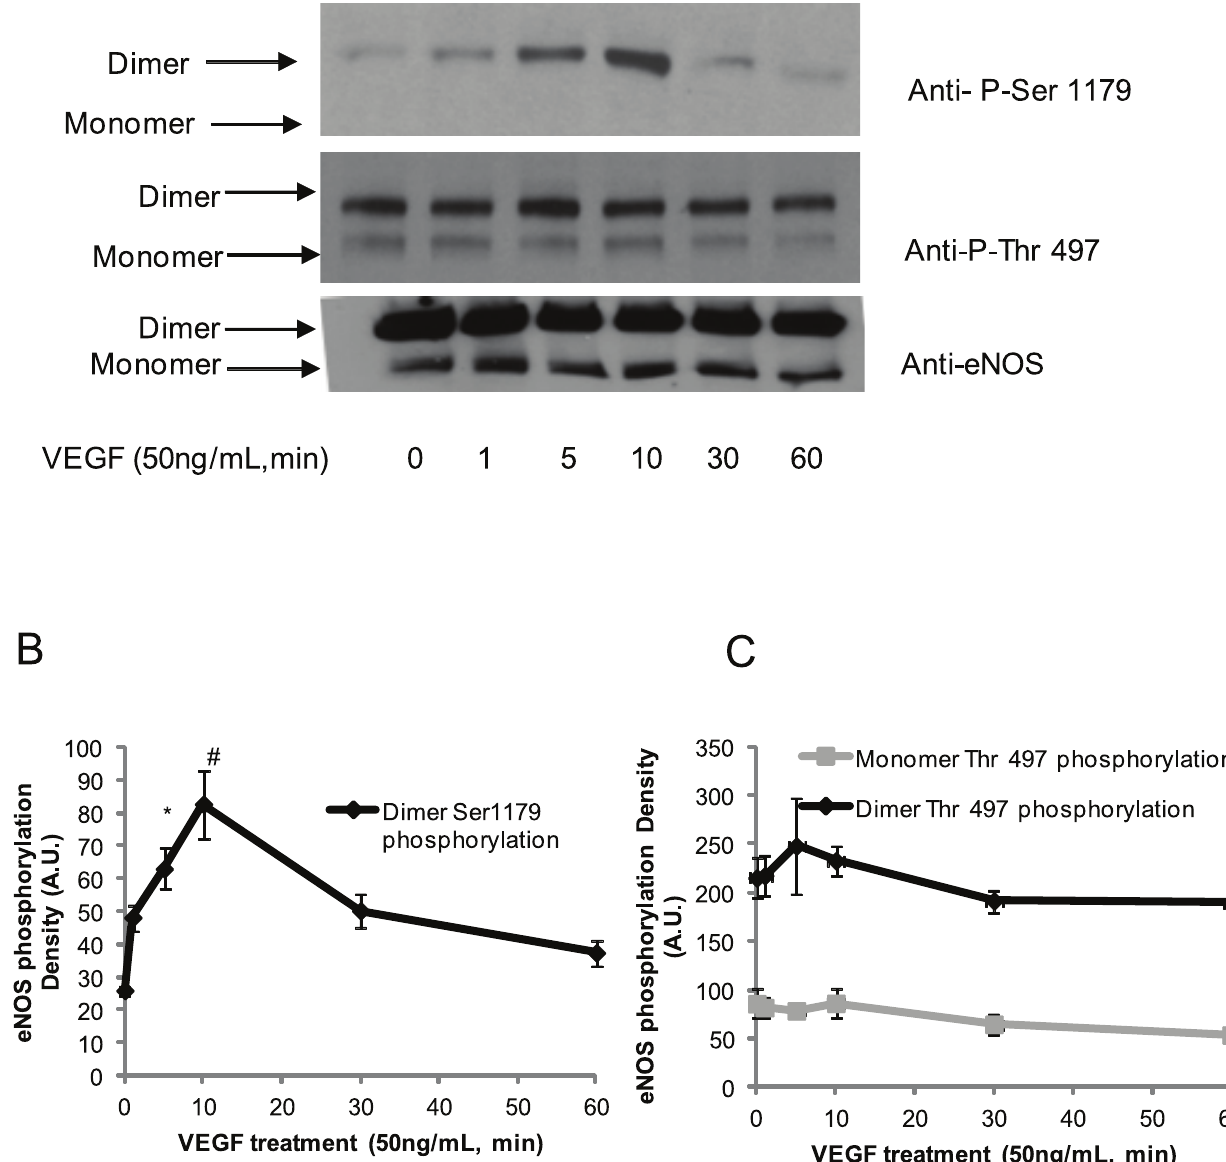
Figure 3. VEGF changed the Serine 1179 phosphorylation status in dimers only and did not alter the phosphorylation status of Threonine 497 in eNOS dimers or monomers. (A) After serum starvation for two hours, BAECs were treated with VEGF (50 ng/ml) for indicated time. The cell lysates were run on SDS-PAGE gels at low temperature. After transferring the protein to nitrocellulose membranes, they were probed with the indicated antibodies. (B) eNOS dimer Ser1179 phosphorylation density was determined by AlphaImager and normalized with control. The results were representative of three independent experiments. (C) The Thr497 phosphorylation density on eNOS dimer and monomer was determined by AlphaImager and normalized with control. The results were represented from three independent experiments (*P , 0.05 comparing to control).